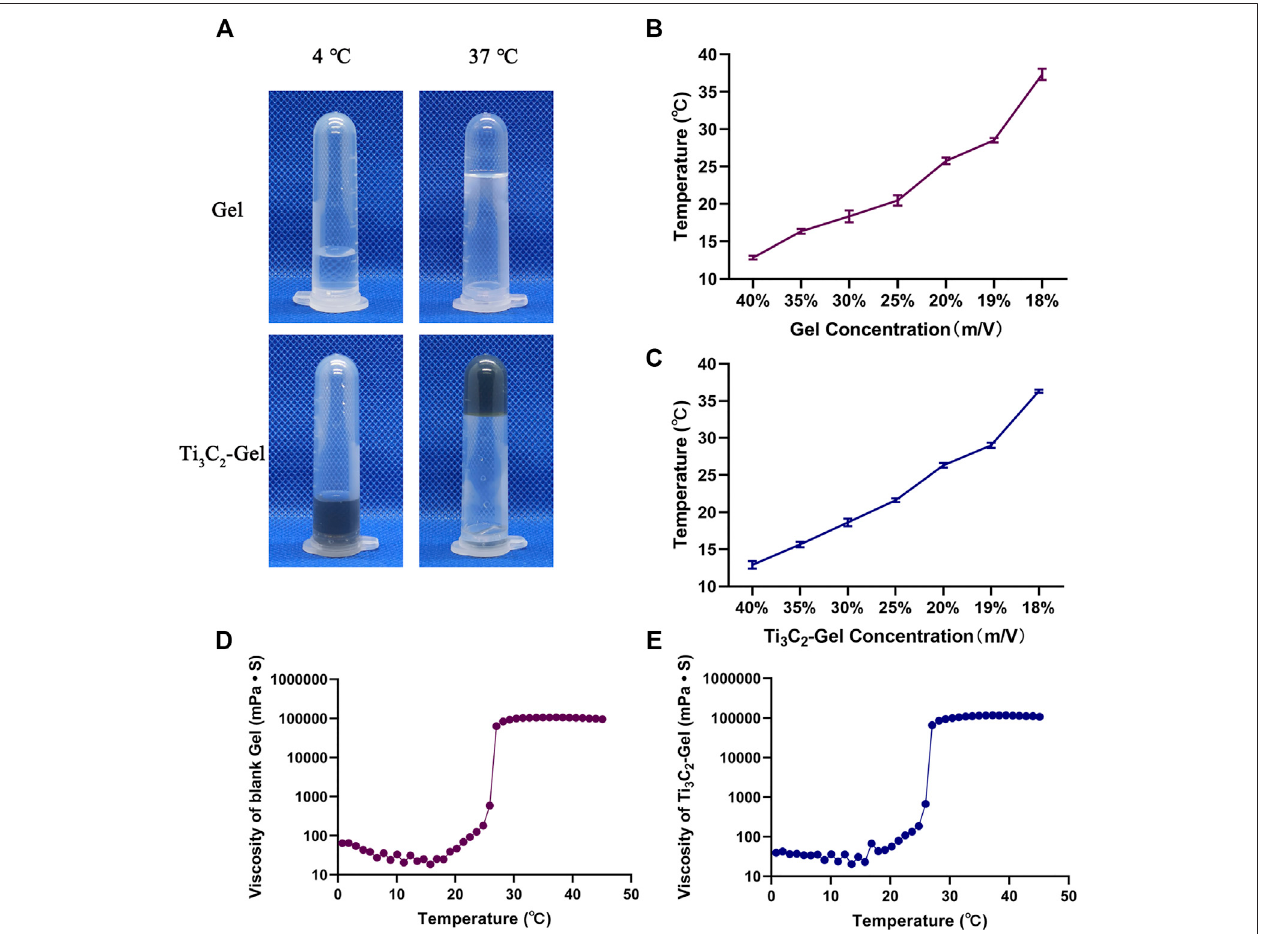
FIGURE 3 | Assessment of photothermal properties. (A) Morphology of Pluronic F127 gel and Ti 3 C 2 -gel at 4 ° C and 37 ° C. (B,C) Phase transition temperature of PluronicF127geland Ti 3 C 2 -Gel(concentrationofTi 3 C 2 was50 μ g/ml). (D,E) RheologicalpropertiesofPluronicF127and Ti 3 C 2 -gel(concentrationofPluronicF127was 20%, and that of Ti 3 C 2 was 50 μ